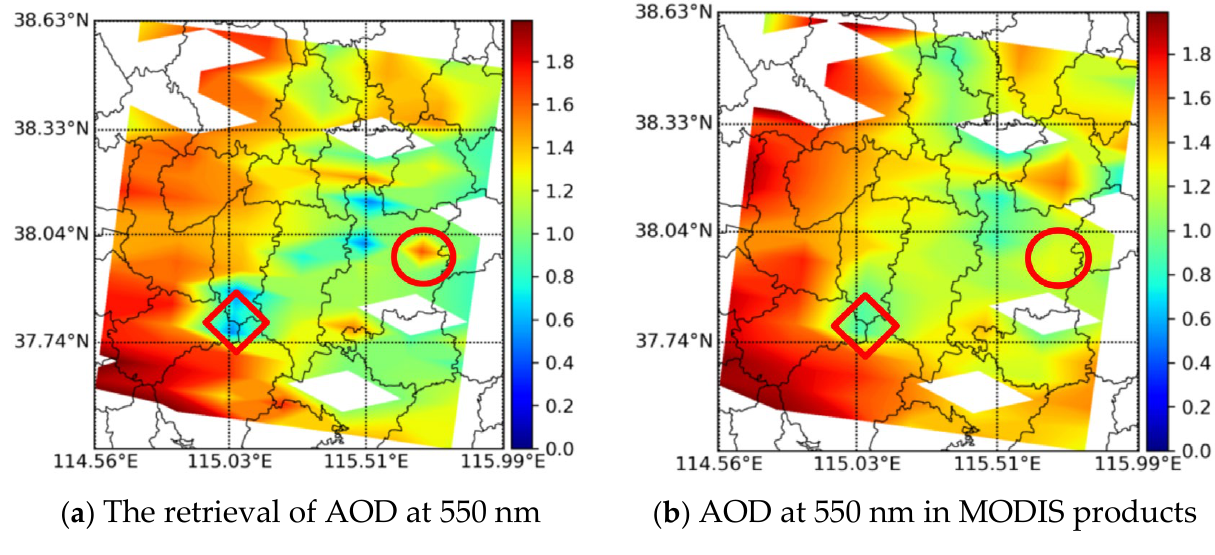
Figure 6. POSP AOD inversion results ( a ) vs. MODIS products ( b ) (9 June 2022).